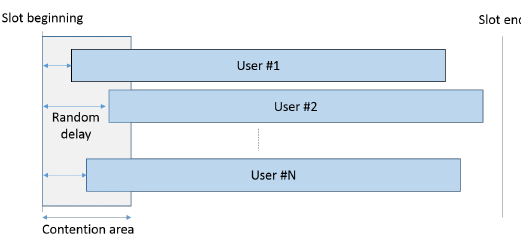
Figure 5. RPMA Multiple Access Principle adapt the data rate to the propagation conditions. For the uplink, or the downlink broadcast transmission, a unique Gold code is used. On the contrary, for unicast downlink transmission, the Gold code is built with the end-device ID, such that no other end-device is able to decode the